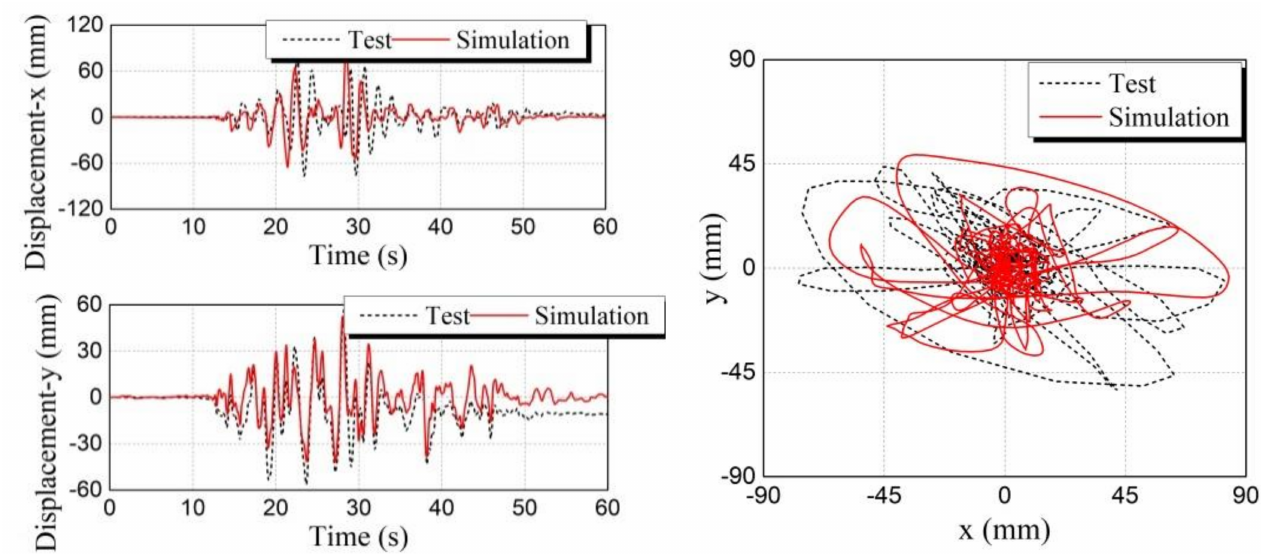
Figure 37. Comparisons between experimental and simulated results of the b300d380 bearing under ChiChi-TCU122 ground motion (low-frequency) with PGA of 2 m/s 2